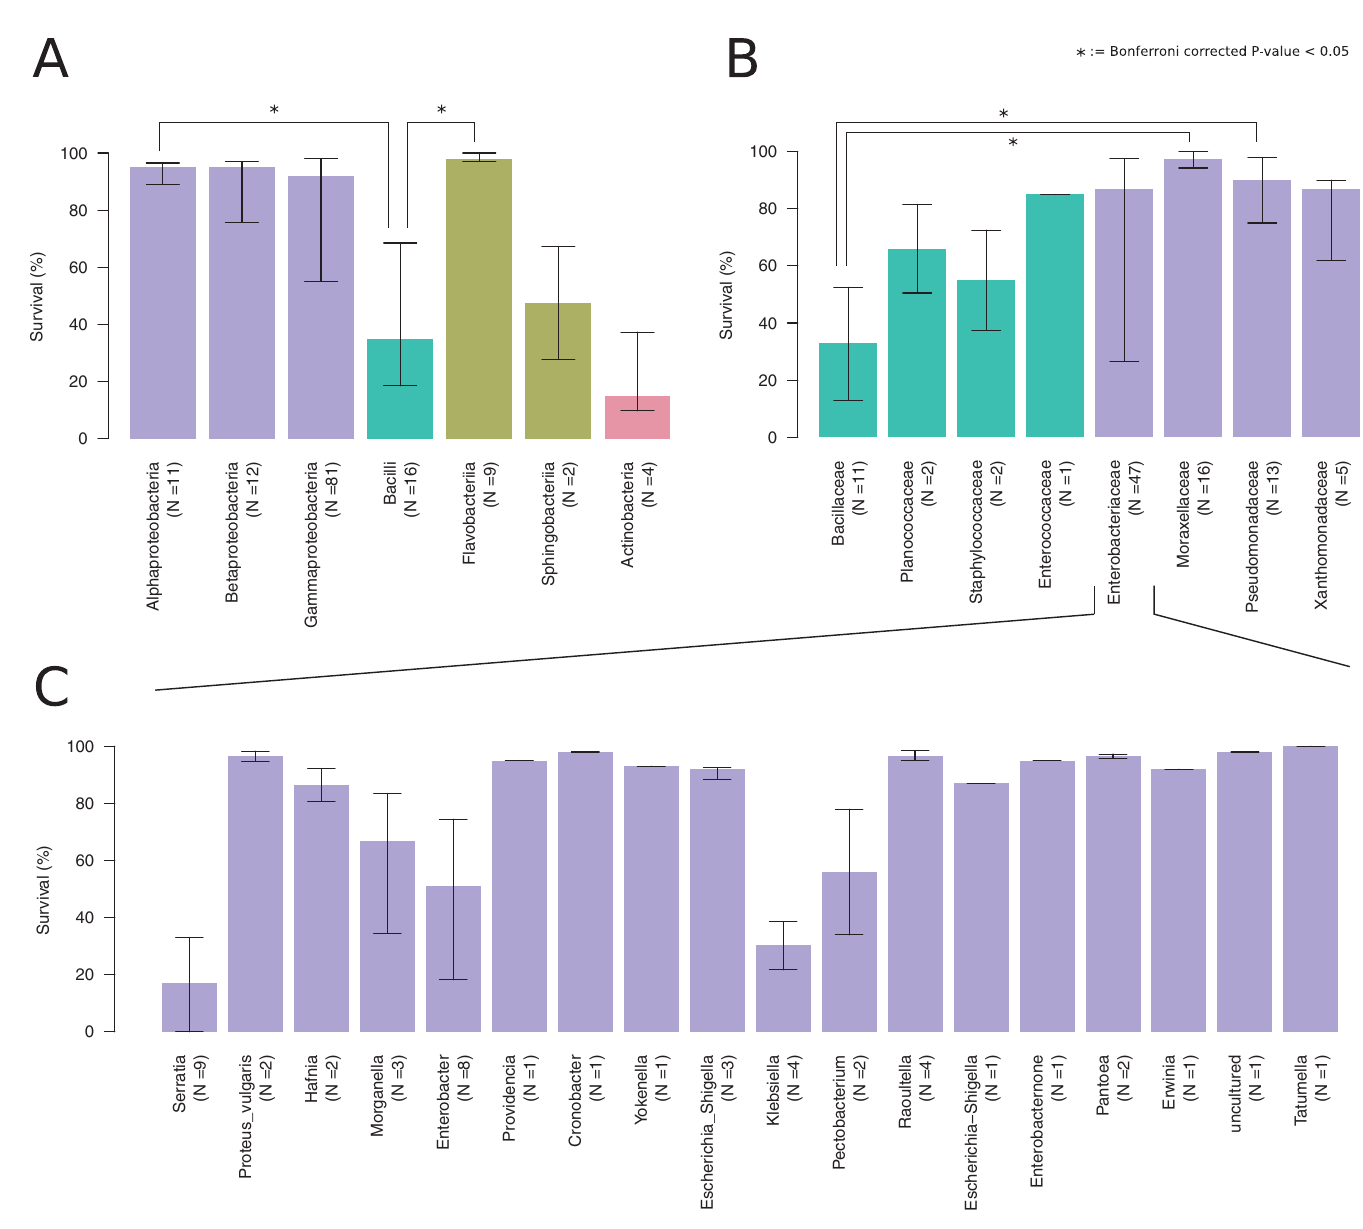
Fig 3. Survival of P . pacificus nematodes on different bacteria. (A) Bars show median and interquartile ranges of survival of P . pacificus worms in response to various bacterial classes. All pairwise tests for significantly different survival were done by a Wilcoxon rank-sum test. Results that remained significant after Bonferroni correction are highlighted. (B) Distribution of survival rate for deeply sampled and highly variable bacterial classes (Bacilli and Gammaproteobacteria) at higher phylogenetic resolution (family level). Within the class Bacilli, decreased survival is mostly due to strains of the family Bacillaceae. Within the class Gammaproteobacteria, the largest variability in nematode survival is observed in the family Enterobacteriaceae. (C) Distribution of survival within Enterobacteriaceae at genus level.